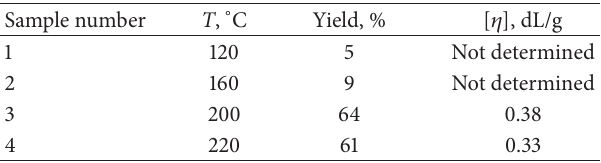
Table 1: Reaction yield and polymer intrinsic viscosity at stannous octoate initiated ROP of